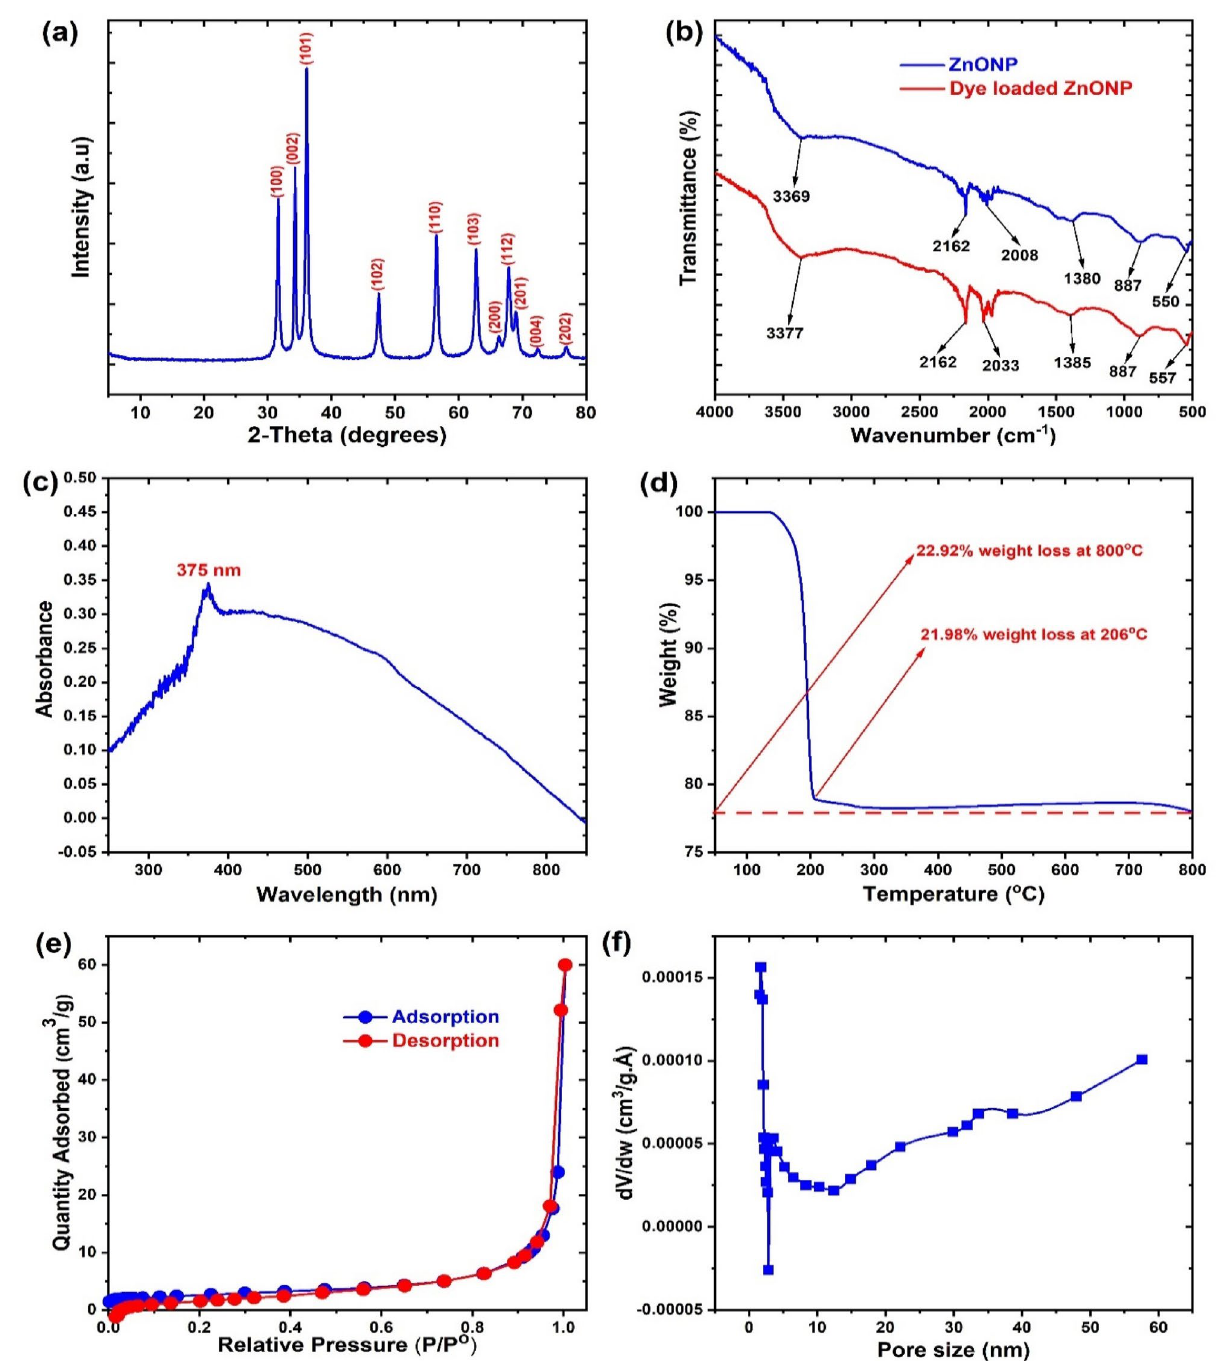
Figure 1. The ( a ) X-ray diffraction ( b ) Fourier transform infrared ( c ) Ultraviolent spectra (d ) Thermogravimetric analysis ( e ) Nitrogen adsorption–desorption isotherm and ( f ) Pore analysis of the synthesized